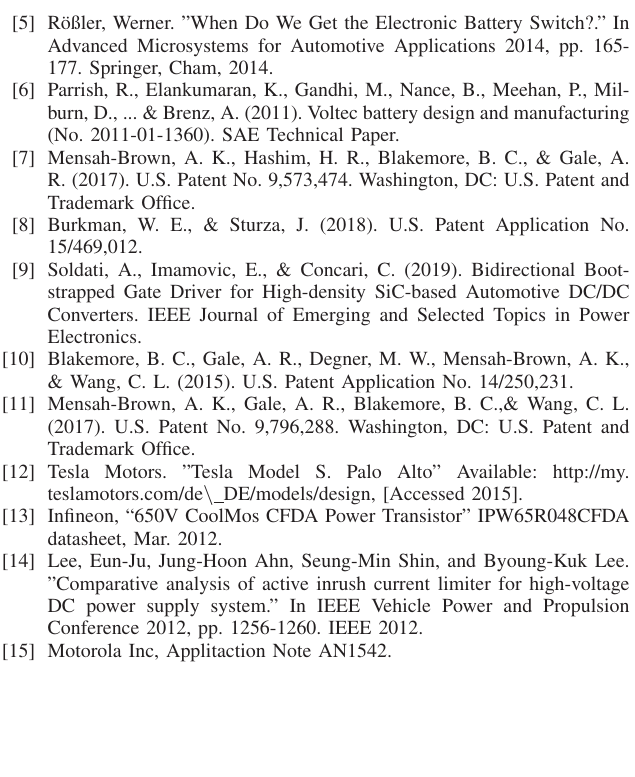
Fig. 10. Power dissipation on